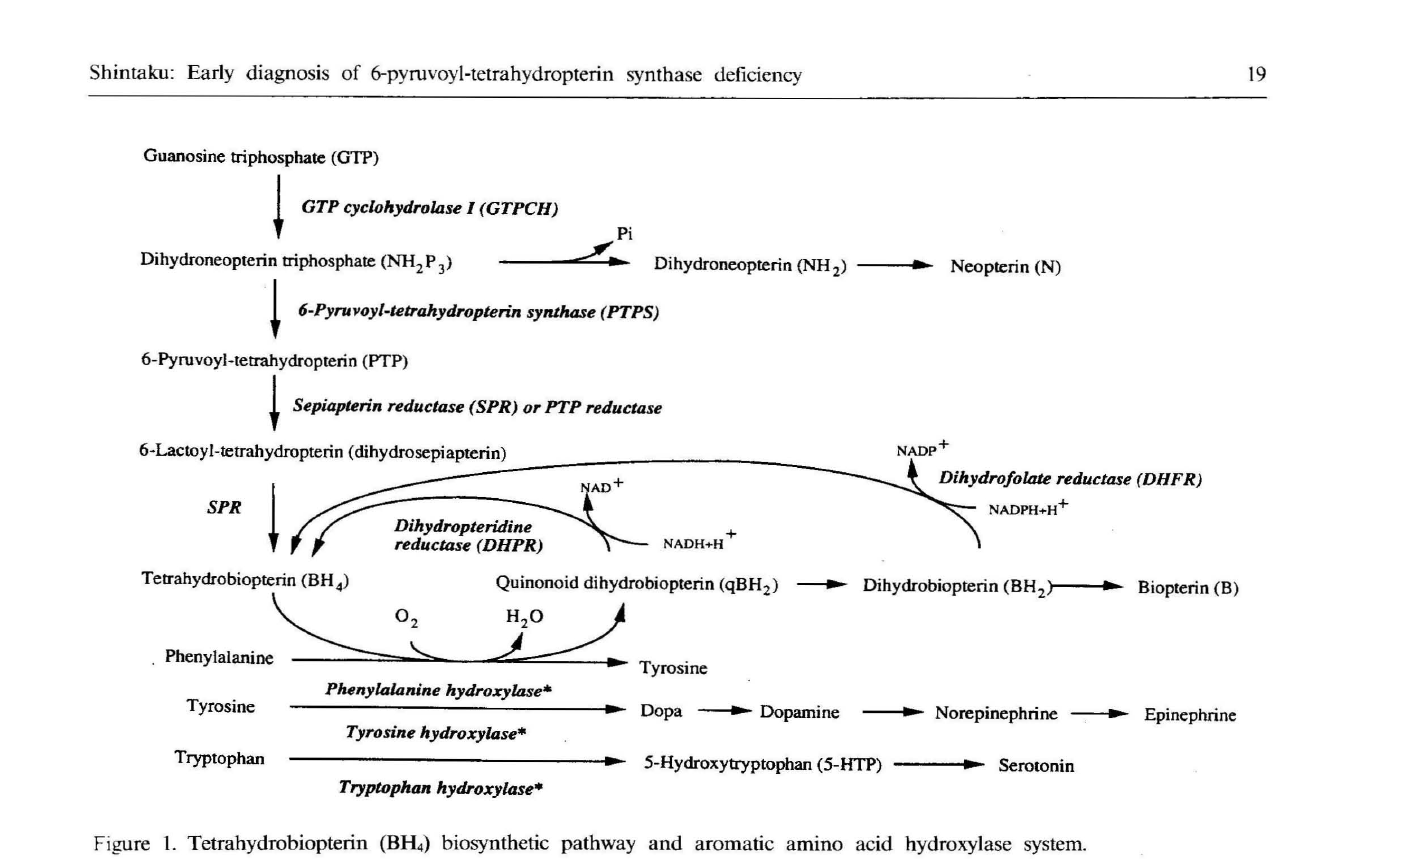
Figure 1. Tetrahydrobiopterin (BH4) biosynthetic pathway and aromatic amino acid hydroxylase system.